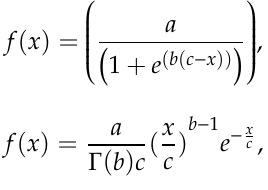
Figure S1: All datasets complete with peaking and saturating curves after parameter estimation and associated AICs., Tables S1–S12: Level of evidence towards peaking or saturation curve shapes for all data sets, organised by response type. Supplementary S1a lists the papers analysed alongside the vectors used in those papers. Supplementary S1b lists the species and origin of these